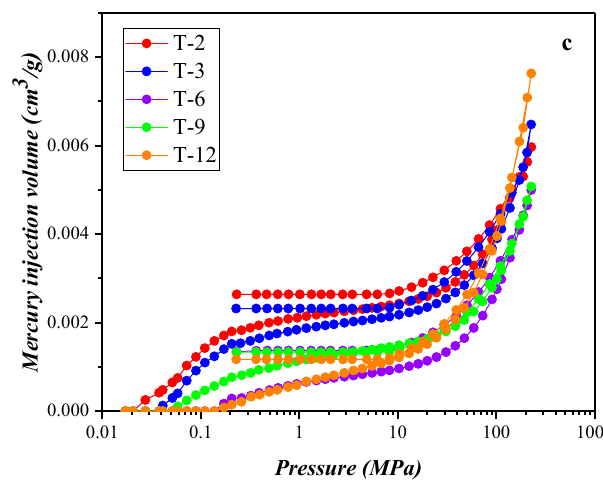
Figure 5. Intrusive mercury curve for the 12 shale samples: ( a ) The shale samples with quite large hysteresis loops, ( b ) The shale samples with medium hysteresis loops, ( c ) The shale samples with quite small hysteresis loops.